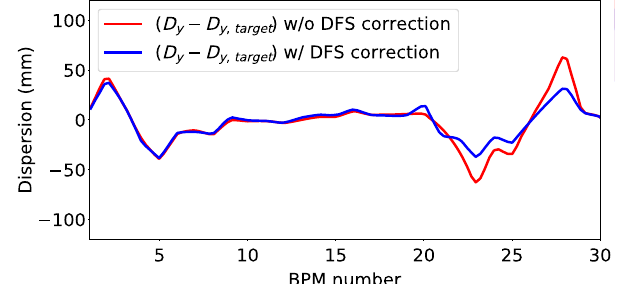
FIG. 5. Difference between the measured vertical dispersion ( D y ) and the target dispersion ( D y; (red) and after (blue) DFS correction.